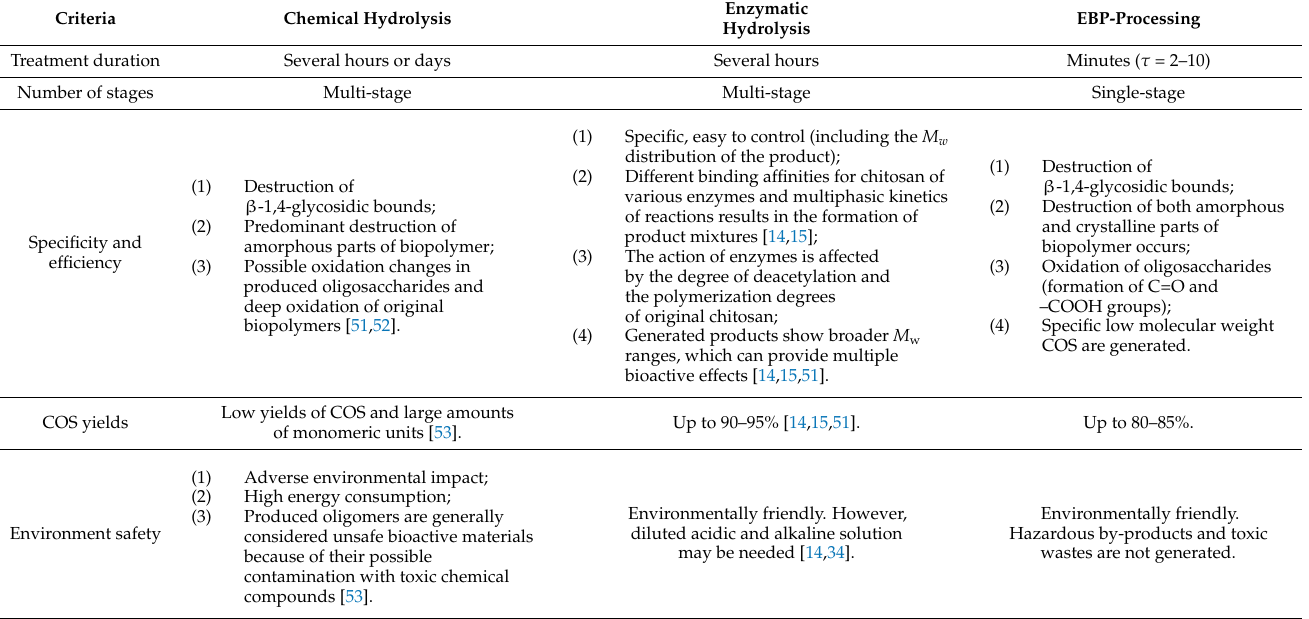
Table 3. The comparison of the EBP-stimulated chitosan destruction with conventional